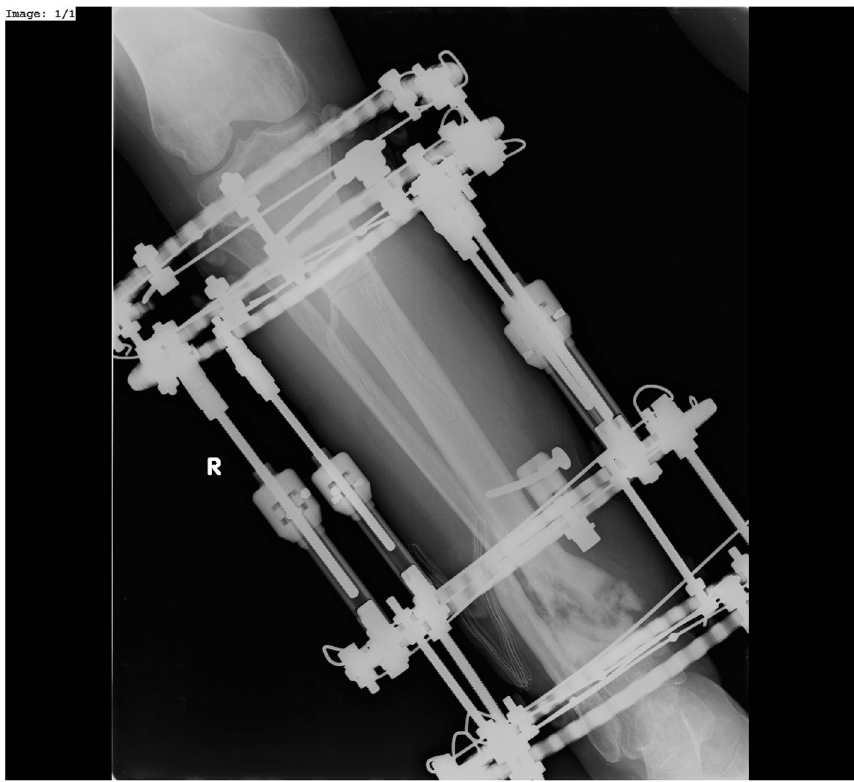
Figure 2. Hypertrophic non-union of 1/3 distal tibia treated by Ilizarov External Fixator (a–p